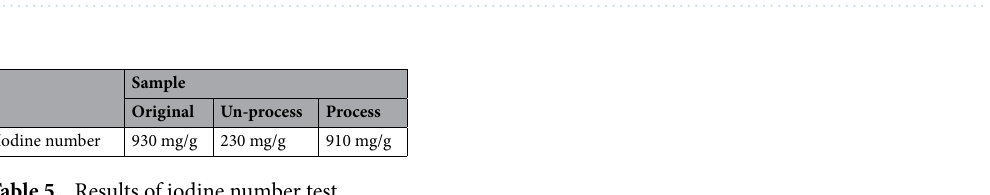
Table 4. Results of gas chromatography.